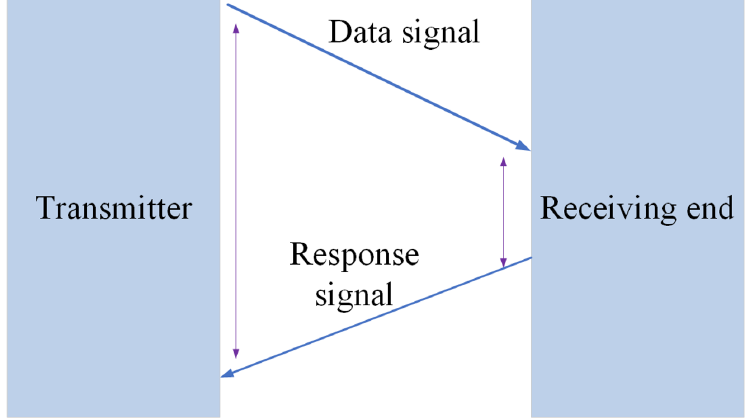
Figure 3. Schematic diagram of TOF ranging